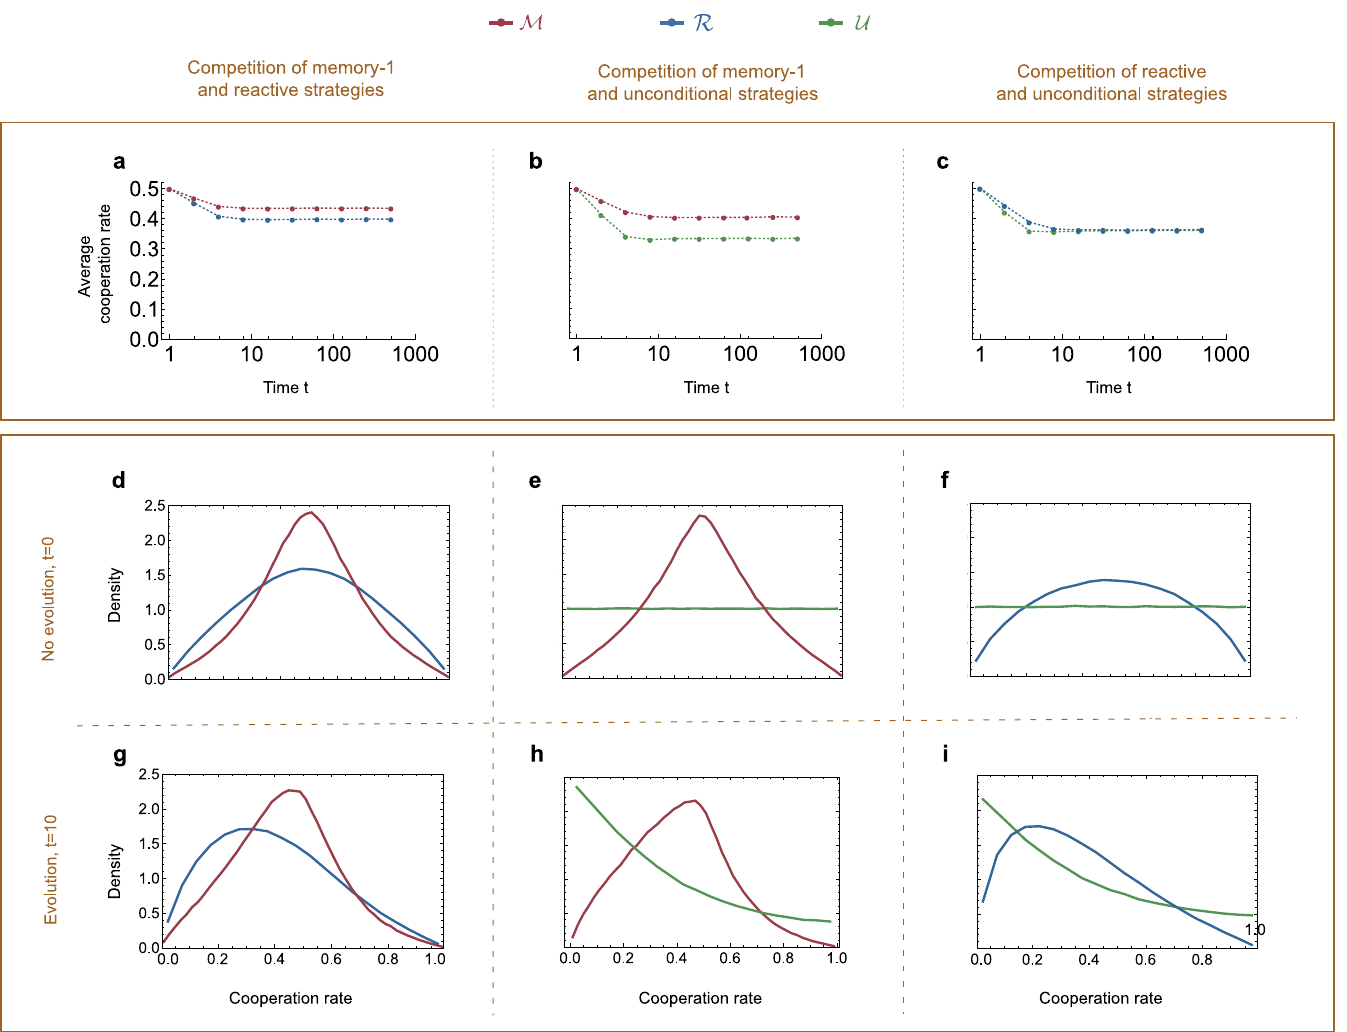
Fig 2. Lower-memory strategies are more likely to discover strategies with extreme cooperation rates. Here, we study the distribution of the players’ cooperation rates when two players with different memory capacity interact ( M vs R , M vs U , R vs U ). In panels a–c , we show that the mean of this distribution stabilizes after at most t = 10 timesteps, for each combination of memory spaces. In d-f , we present this distribution in the very beginning of the process, when players choose their strategies uniformly at random from their respective memory space. In g-i , we show how the distribution of cooperation rates changes after 10 time steps of introspection dynamics (for c = 0.5 and β = 10), which is the time it takes for the difference in average cooperation rates to stabilize. In both cases, we observe that players with lower memory capacities are more likely to choose strategies with extremal cooperation rates (a cooperation rate close to zero or one). To create this graph, we have randomly sampled 10 6 pairs of strategies from the respective memory spaces. For each pair, we have then simulated t = 10 time steps of introspection dynamics. The curves show the result when we bin the players’ cooperation rates in steps of 0.02 and renormalize (such that the area under each curve is one). The above plots show marginal distributions for each memory-space. In contrast, S5 and S6 Figs show joint distributions for each possible combination of memory spaces.